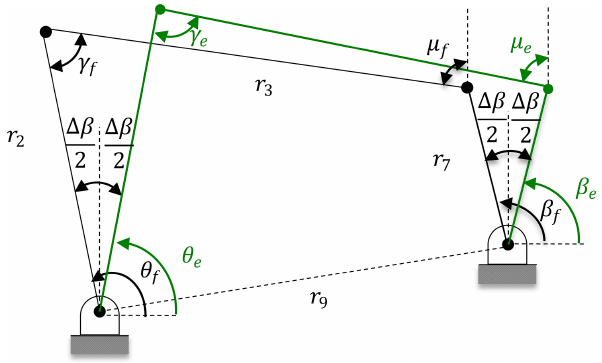
Figure 6. Four-bar mechanism in forward and fully withdrawn po- sitions.